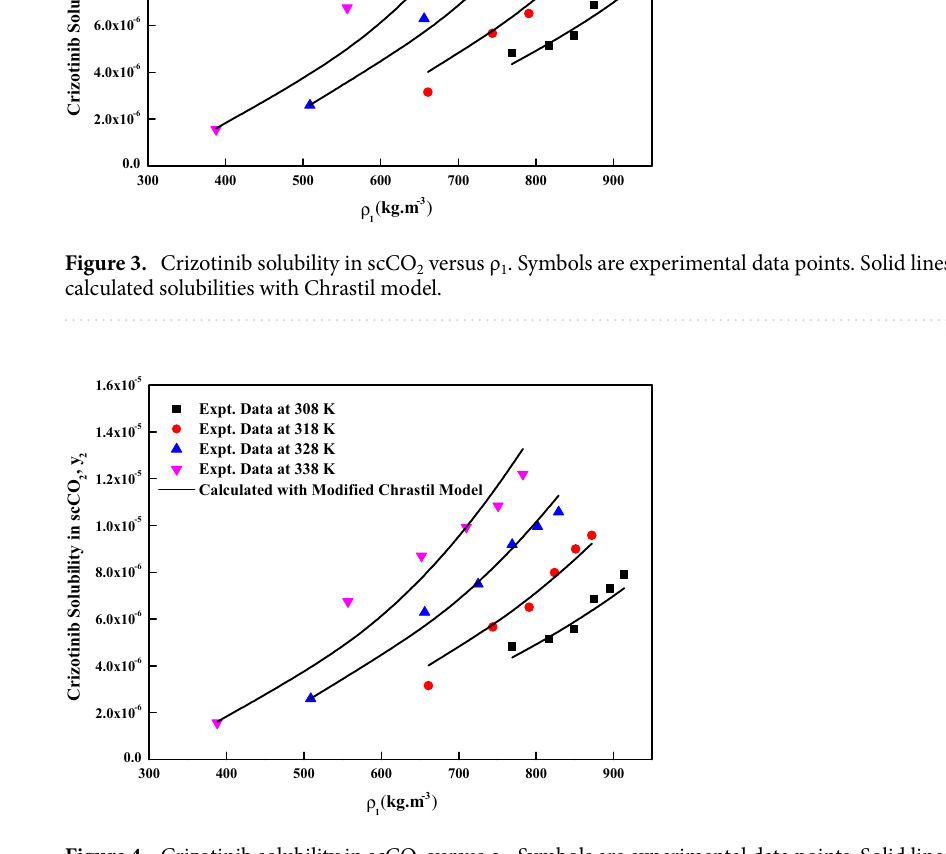
Figure 4. Crizotinib solubility in scCO 2 versus ρ 1 . Symbols are experimental data points. Solid lines are calculated solubilities with Modified Chrastil